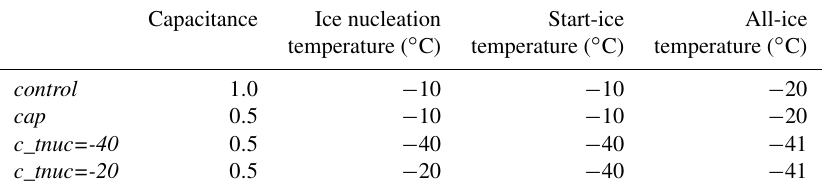
Table 1. Values used in the model runs.